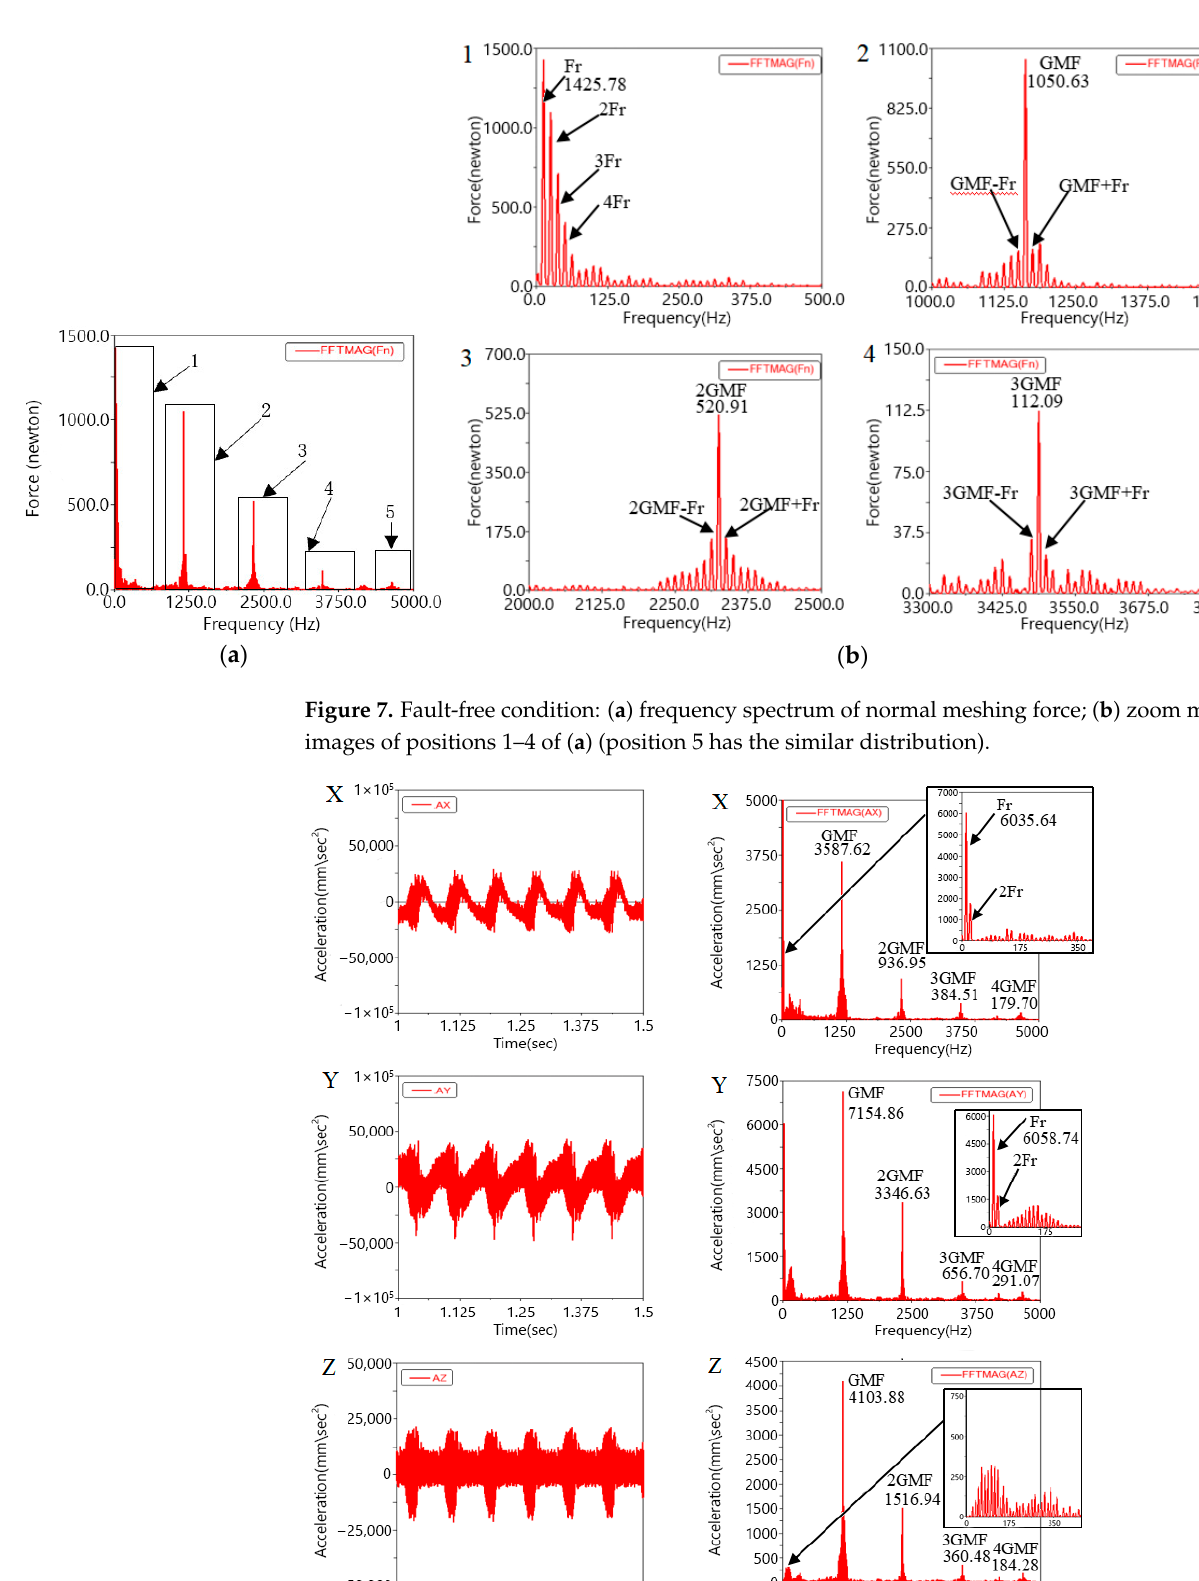
Figure 8. ( a ) Vibration acceleration in x, y, and z directions; ( b ) frequency spectrum in x, y, and z directions.